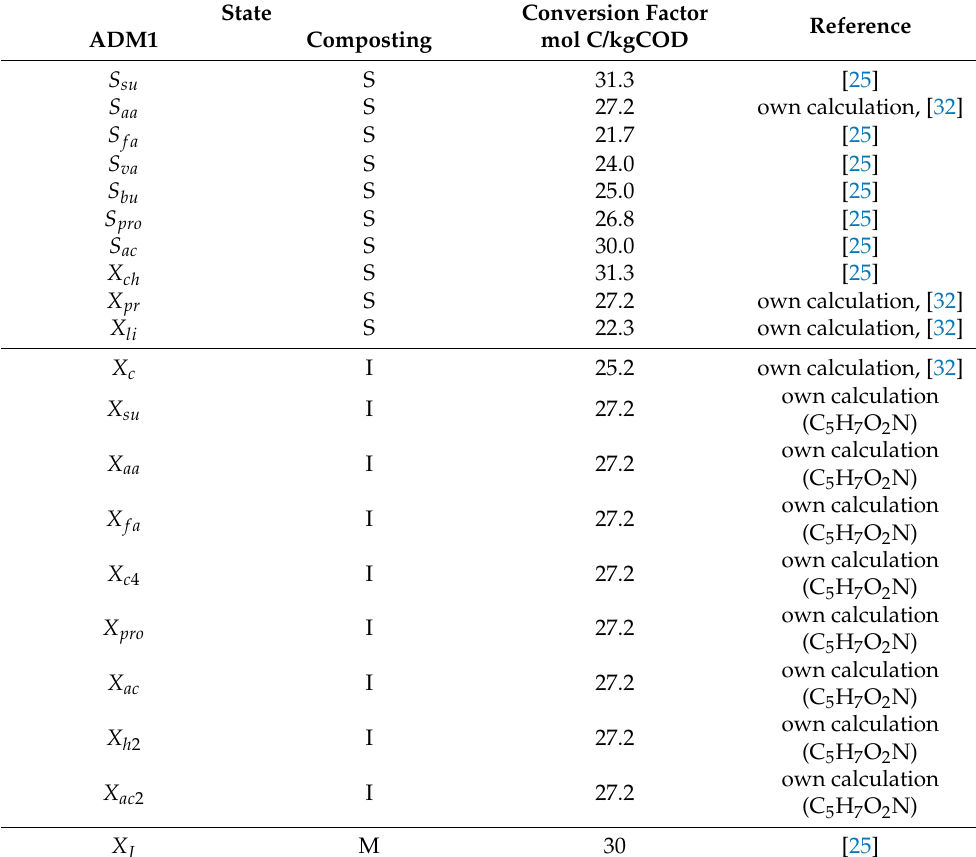
Table 3. Conversion factors from anaerobic digestion to composting.